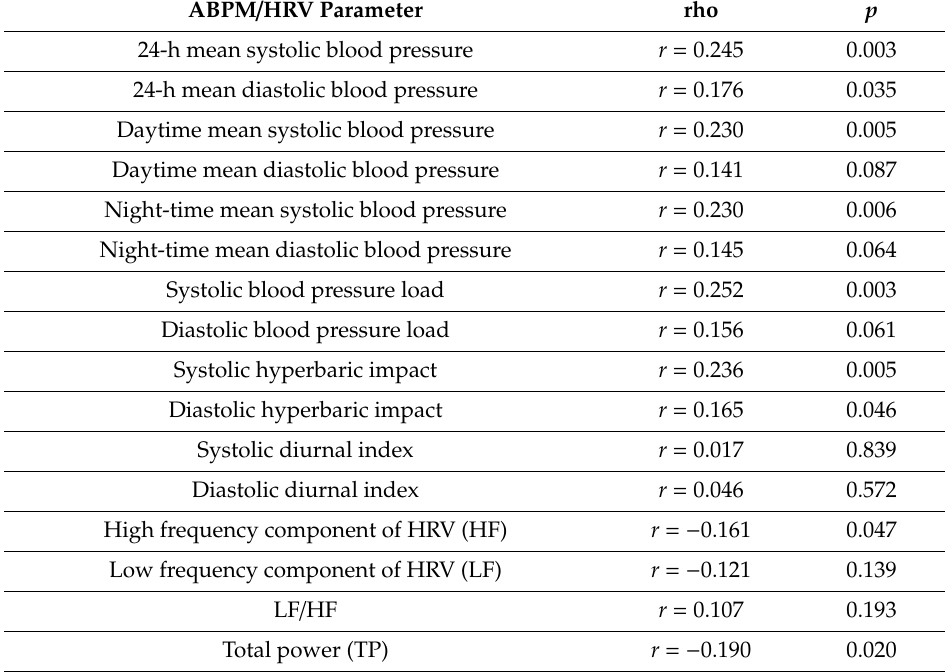
Table 3. Correlations between 24-h ambulatory blood pressure (ABPM) and heart rate variability (HRV) parameters and diastolic blood pressure elevations in response to sustained handgrip test.